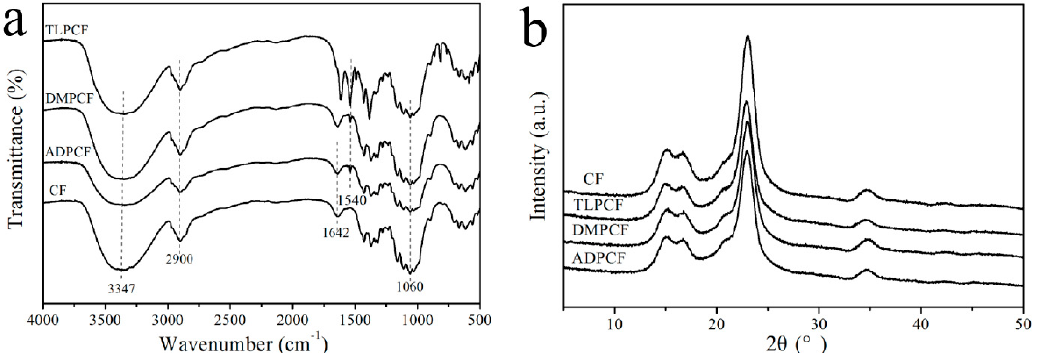
Figure 5. ( a ) FTIR spectra of control cotton fabric and TLP-, DMP-, and ADP-modified cotton fabrics; ( b ) XRD of control cotton fabric and TLP-, DMP-, and ADP-modified cotton fabrics.